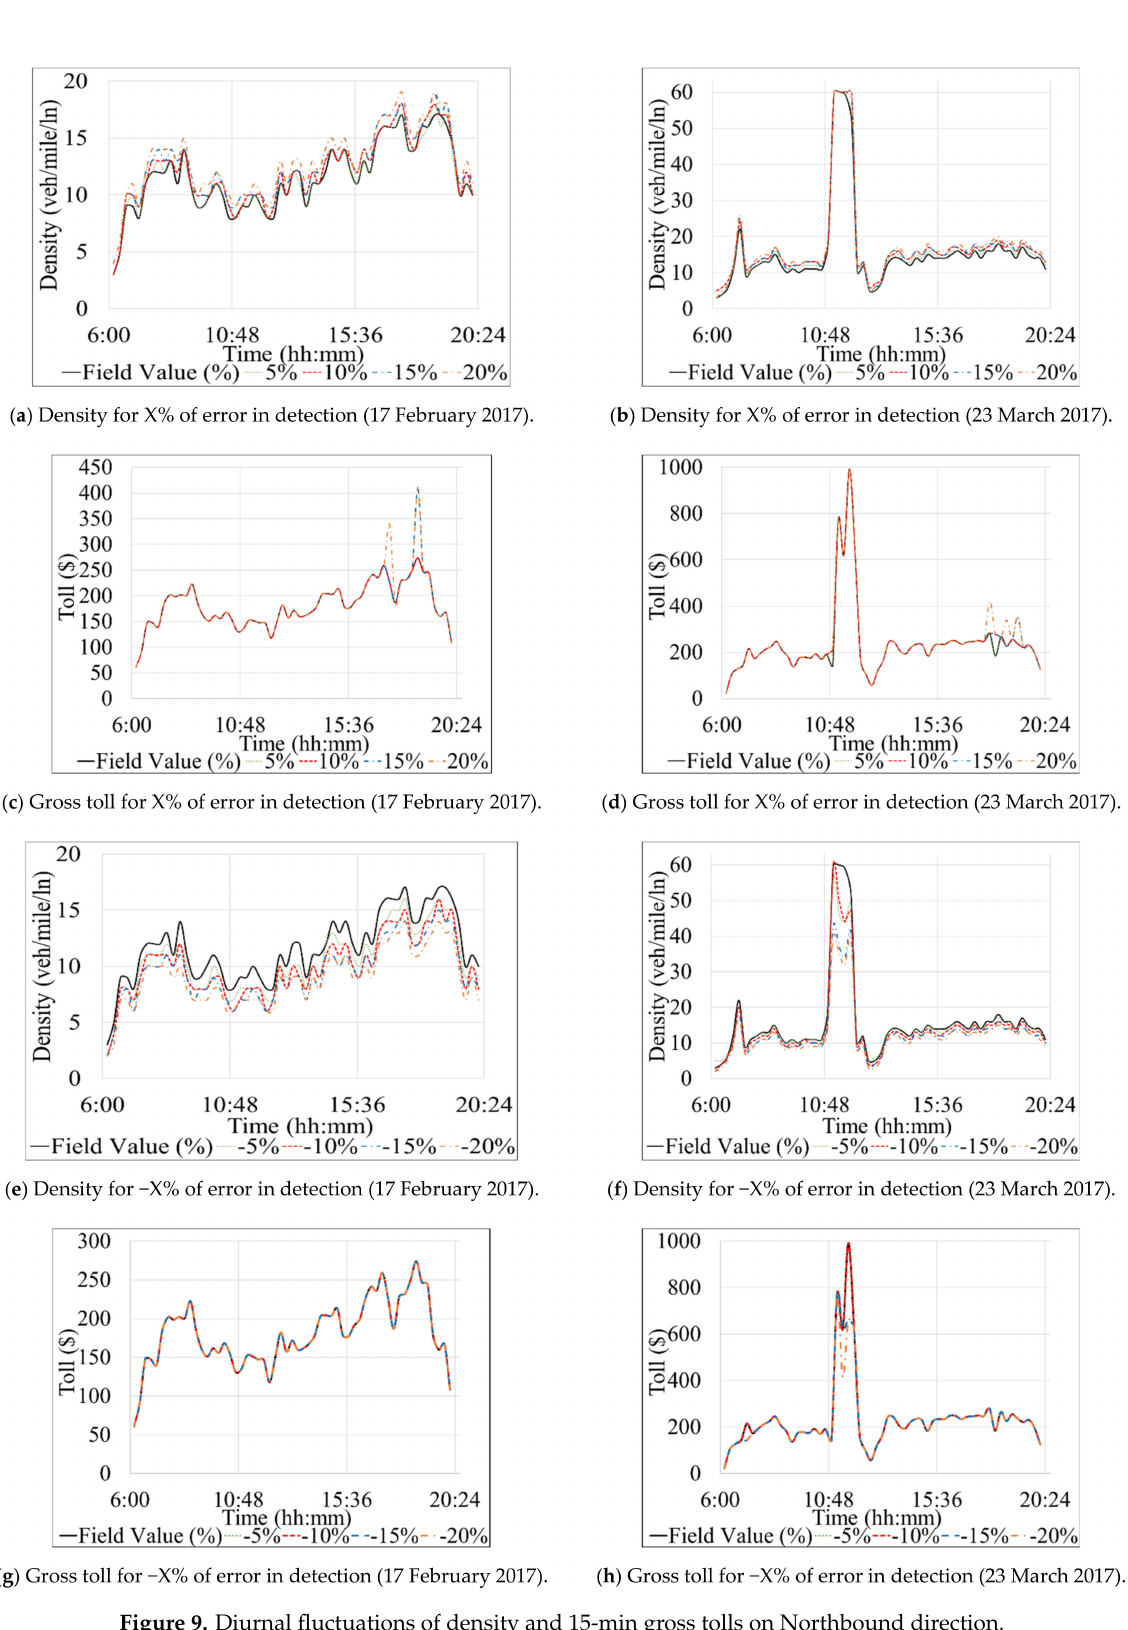
Figure 9. Diurnal fluctuations of density and 15-min gross tolls on Northbound direction. The results of the second subset of the systematic detection error experiments for the Northbound segment are presented in Table 6B and the right sections of Figure 8a,b. Experiments #1.19 and #1.20 showed that all experiments with fewer sensors (1–2